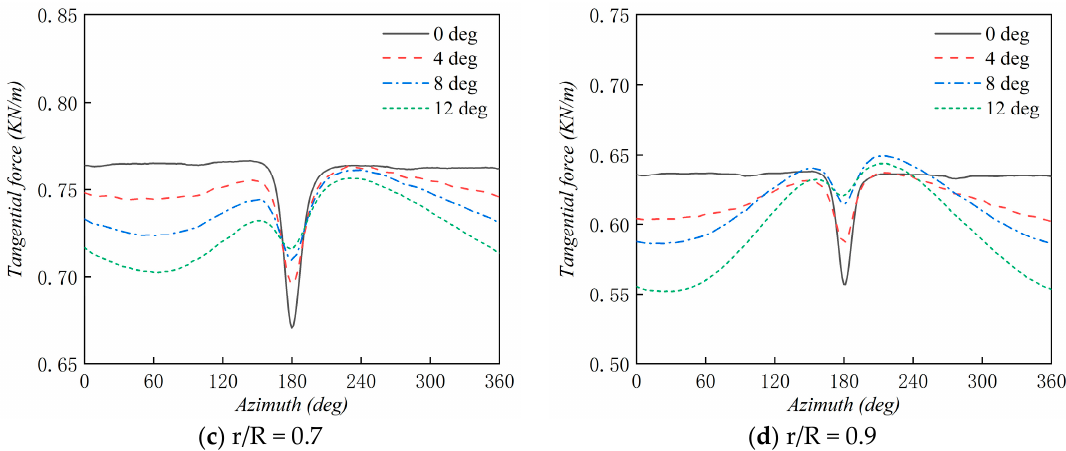
Figure 18. Tangential force per unit of span along the rotor span for Blade 1.